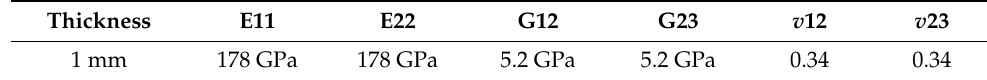
Table 1. Parameters of the orthotropic composite.